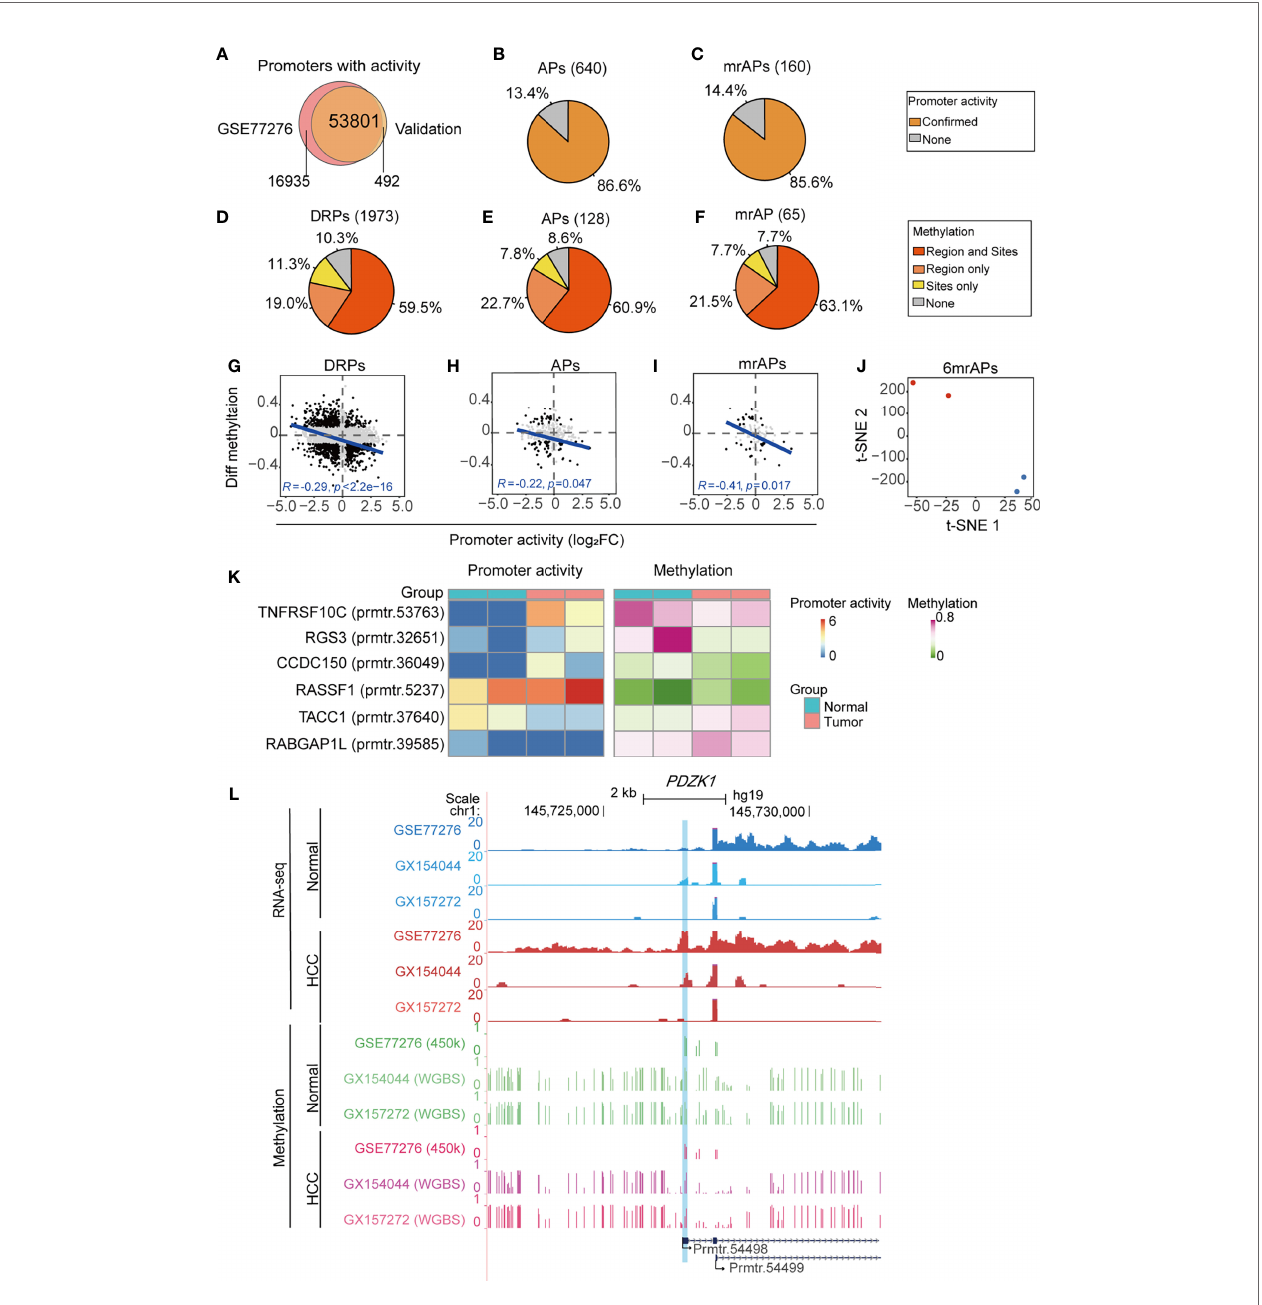
FIGURE 6 | Validation of promoter activity and methylation status by RNA-seq and WGBS. (A) Venn diagram showing the overlap of promoters with activities in our validation dataset of RNA-seq and public dataset of GSE77276. (B, C) The pie chart showing the percentage of all identi fi ed APs (B) and mrAPs (C) in GSE77276 with differential promoter activities being con fi rmed by our validation dataset of RNA-seq. (D – F) The pie chart showing the percentage of all identi fi ed DRPs (D) , APs (E), and mrAPs (F) in GSE77276 with differential methylation status being con fi rmed by our validation dataset of WGBS. Changes of methylation of CpG site (site) with over 0.1 in both public 450K data and our validation WGBS data, and also with the same alteration trends, would be regarded as con fi rmed. The promoter region (region) mean methylation was adopted for testing if the methylation of a CpG site is not available in the WGBS dataset. (G – I) Scatter plots showing the correlation between differential methylation (HCC – normal) and promoter activity by normalized change fold for DRPs (G) , APs (H) , and mrAPs (I), similar to Figures 3D, E, G , but in our validation datasets of RNA-seq and WGBS. (J) The t-SNE plot showing the normal (blue dots) and HCC (red dots) samples in our validation dataset could be grouped by the promoter activities of six mrAPs used in the diagnostic model in Figure 4E . (K) Heatmap showing the promoter activities and methylation status of six mrAPs in our validation data. (L) UCSC genome browser screenshot showing the promoter activities and methylation of gene PDZK1 in both public dataset of GSE77276 and our validation datasets. GSE77276 RNA-seq tracks represent mean read counts of 19 samples, and validation dataset RNA-seq tracks represent read counts for HCC or normal samples from GX154044 and GX157272 separately. GSE77276 450K tracks represent the mean methylation value of 19 samples, and validation dataset WGBS tracks represent methylation ratio for samples from GX154044 and GX157272